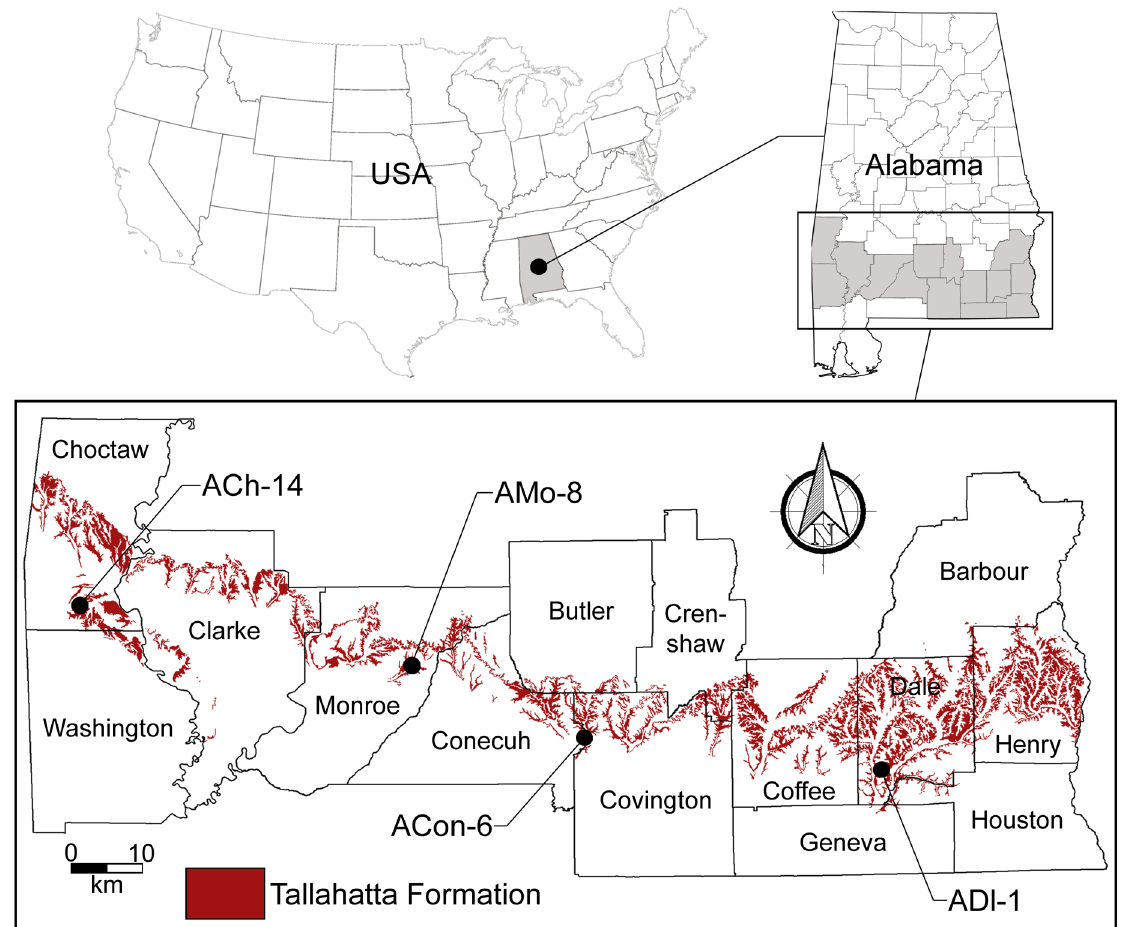
Fig. 2. Tallahatta Formation surface exposures in Alabama, with sampled localities indicated by closed